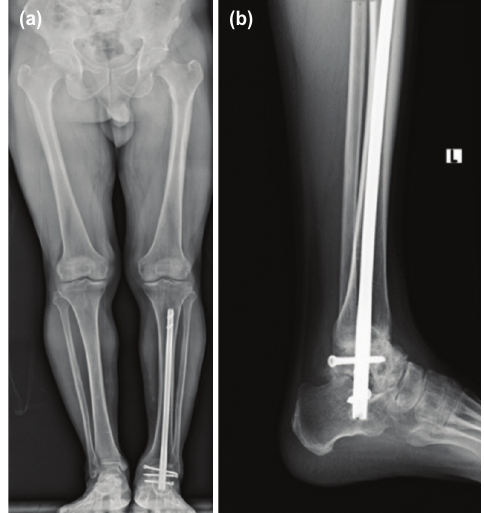
(a, b) AP and lateral radiographs of Patient 4 at follow-up of 12 Fig.3: